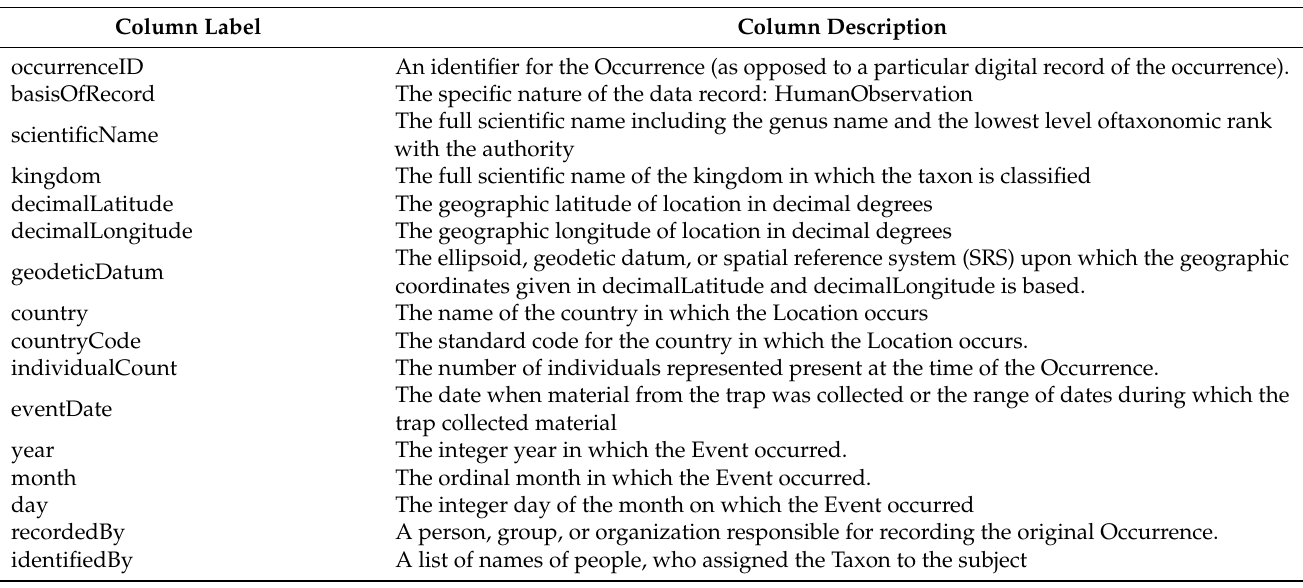
Table 1. Description of the data in the